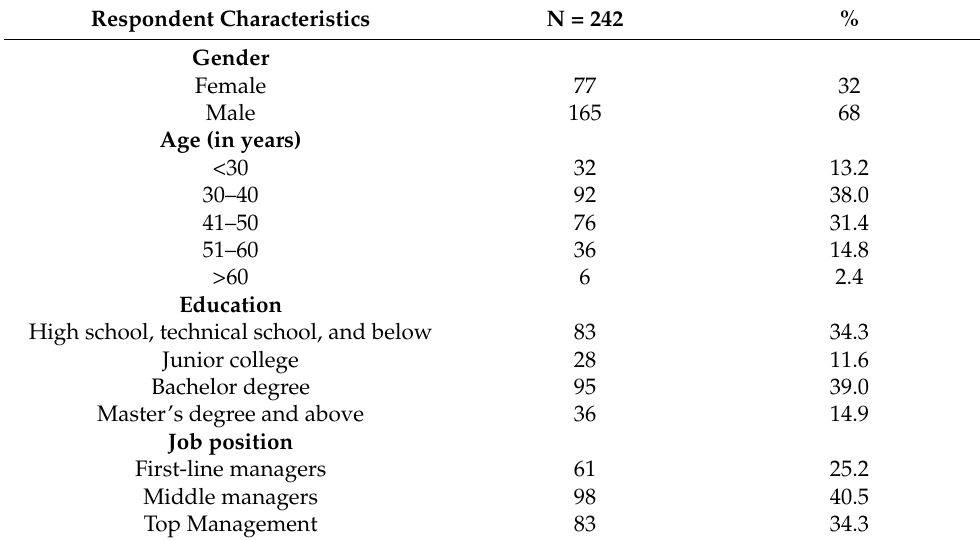
Table 1. Demographic Details of